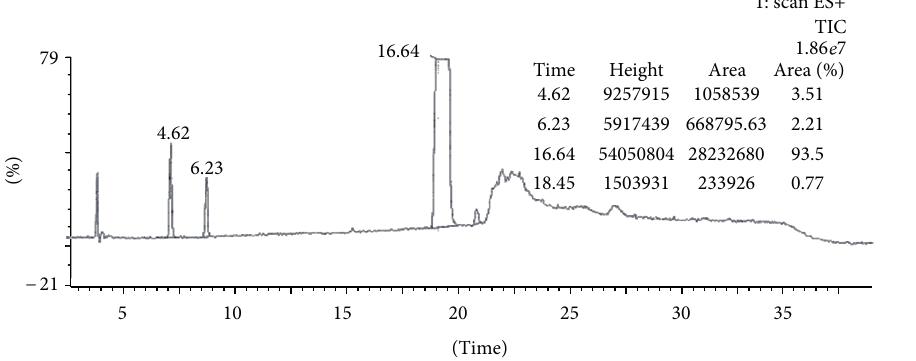
F 13: MS spectrum of impurity-C at RRT